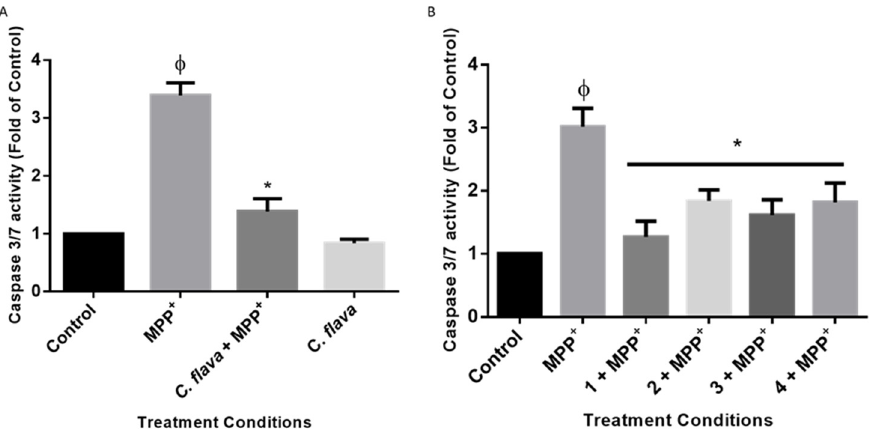
Figure 7. C. flava and compounds inhibited MPP + -induced caspase 3/7 activity. Cells were pre- treated with 2.5 µg/mL of extract ( A ) and compounds ( B ) before exposure to 2000 µM of MPP+ for 24 h and activity of caspase 3/7 was determined. Each bar represents the level of caspase 3/7 expressed as a fold of the control, and the significance of the difference is indicated with * when extract/compounds are compared to MPP + and φ (MPP + vs.